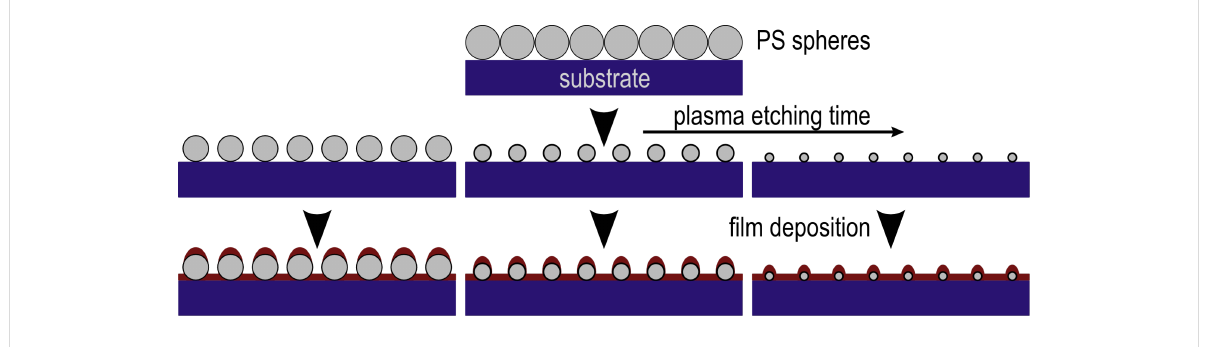
Figure 2: Schematics of the sample preparation. Self-assembled, close-packed monolayers of PS spheres are deposited on a substrate. Isotropic oxygen-plasma etching results in the homogeneous size reduction of PS particles. Finally, a magnetic film is deposited onto the substrates and capped by a thin Pt layer for oxidation